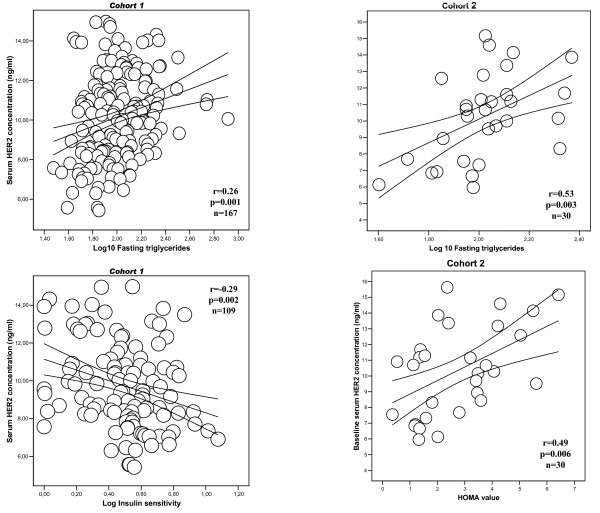
Linear relationhip between serum HER-2 concentration and log-fasting triglycerides and insulin resistance in subjects from Cohort 1 [left panels] and in subjects from the weight loss study [Cohort 2, right panels].